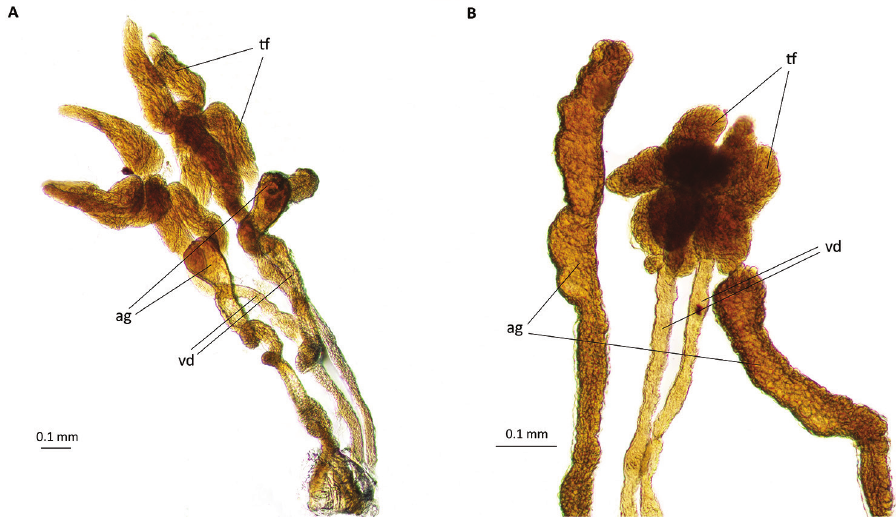
Figure 5. Morphology of the male reproductive system of P. tremulae : A young specimen B mature specimen; ag – accessory gland, tf – testicular follicles, vd – vas deferens.